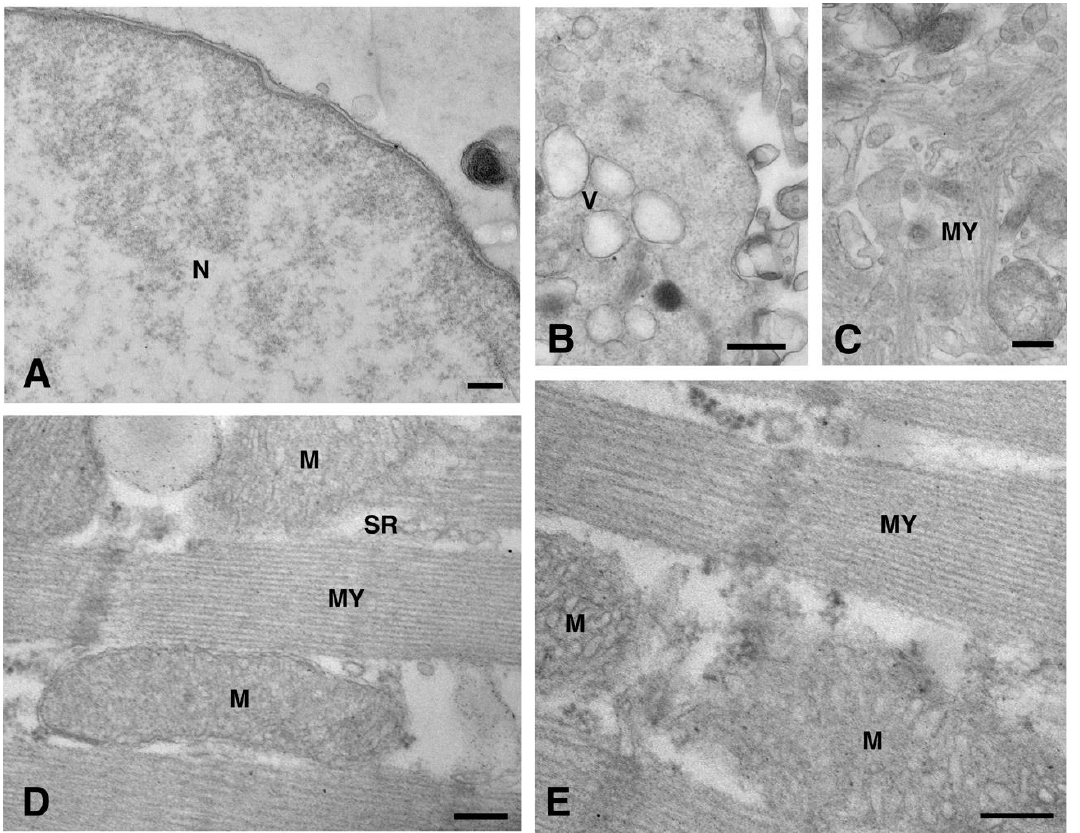
Figure 8. Negative controls for TEM immunogold analysis. Negative controls were obtained by omitting the primary antibody ( A – D ) or by using RαCx32 as primary antibody ( E ). Representative images of dH9c2 cells ( A – C ) and cardiomyocyte sarcoplasm of heart sections ( D , E ) showing no immunoreaction. Scale bars 200 nm ( A , C – E ), 500 nm ( B ). M, mitochondrion; MY, myofibrils; N, nucleus; SR, sarcoplasmic reticulum; V, vesicle.